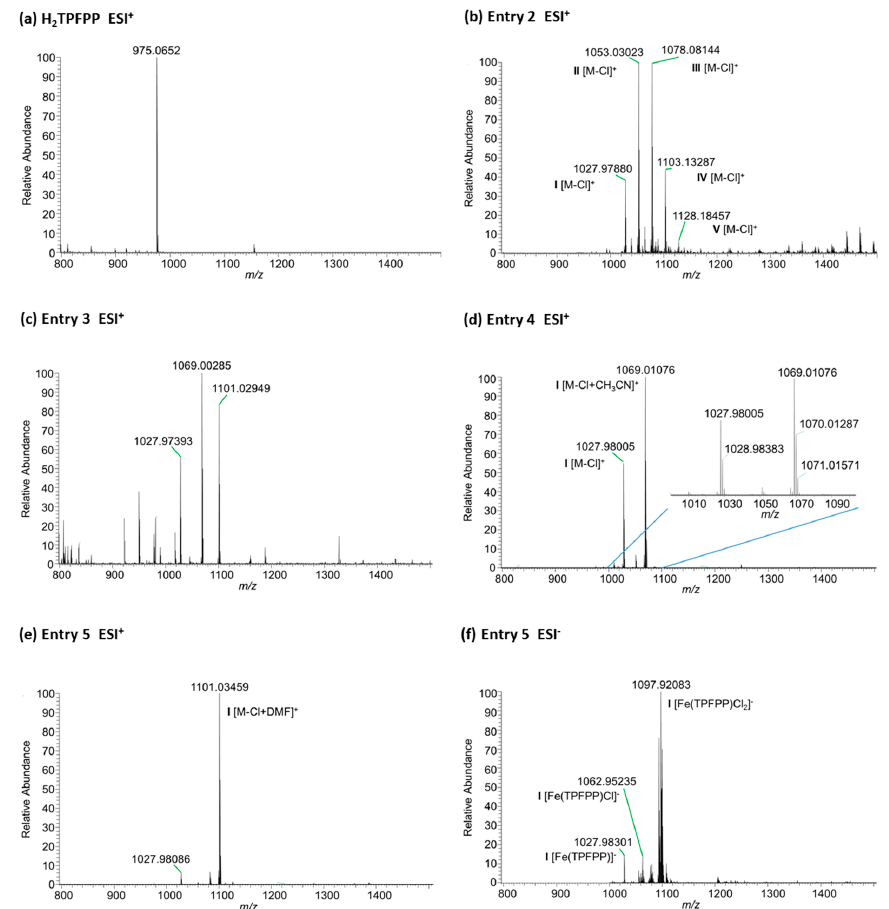
Figure 3. High Resolution ESI mass spectra analysis of H 2 TPFPP ( a ) and of iron complexes obtained